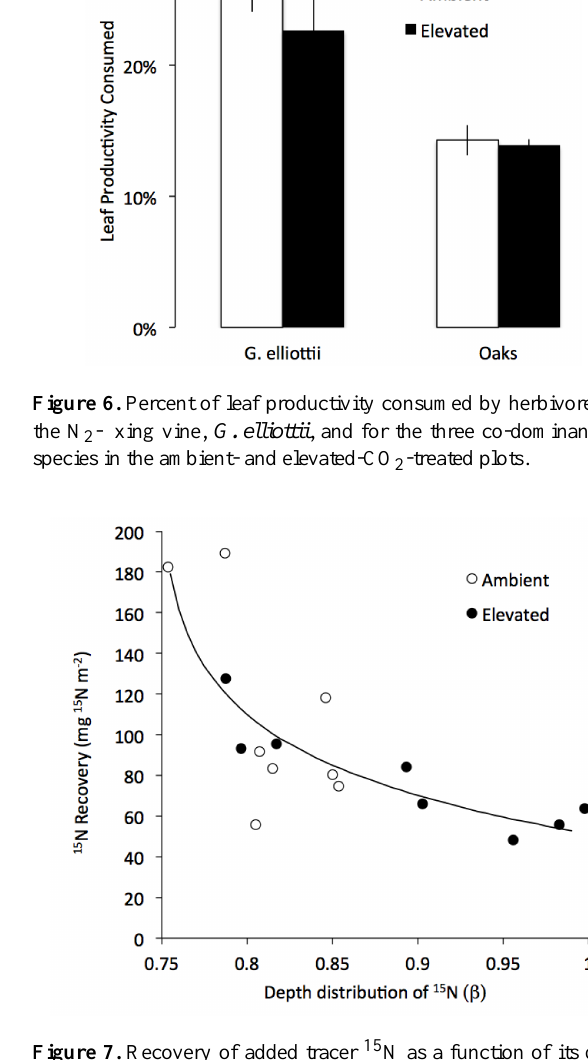
Figure 7. Recovery of added tracer 15 N as a function of its depth distribution. Higher β values indicate relatively more 15 N in deeper soil layers, whereas low β values indicate concentration of 15 N at the soil